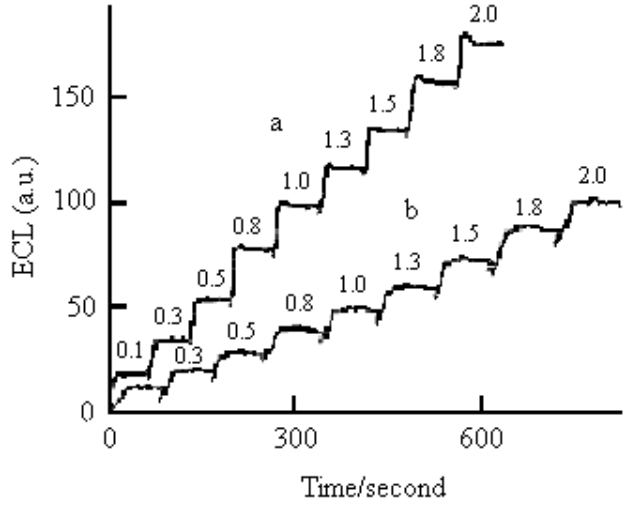
Figure 3. The ECL response of the sensor to oxalic acid without stirring (a) and with stirring (b).